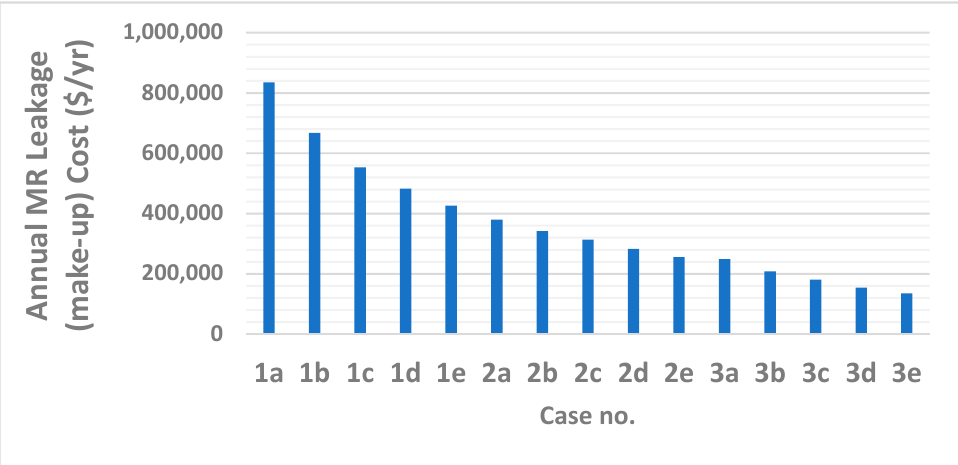
Figure 11. Annual cost of make-up refrigerants due to leakage.